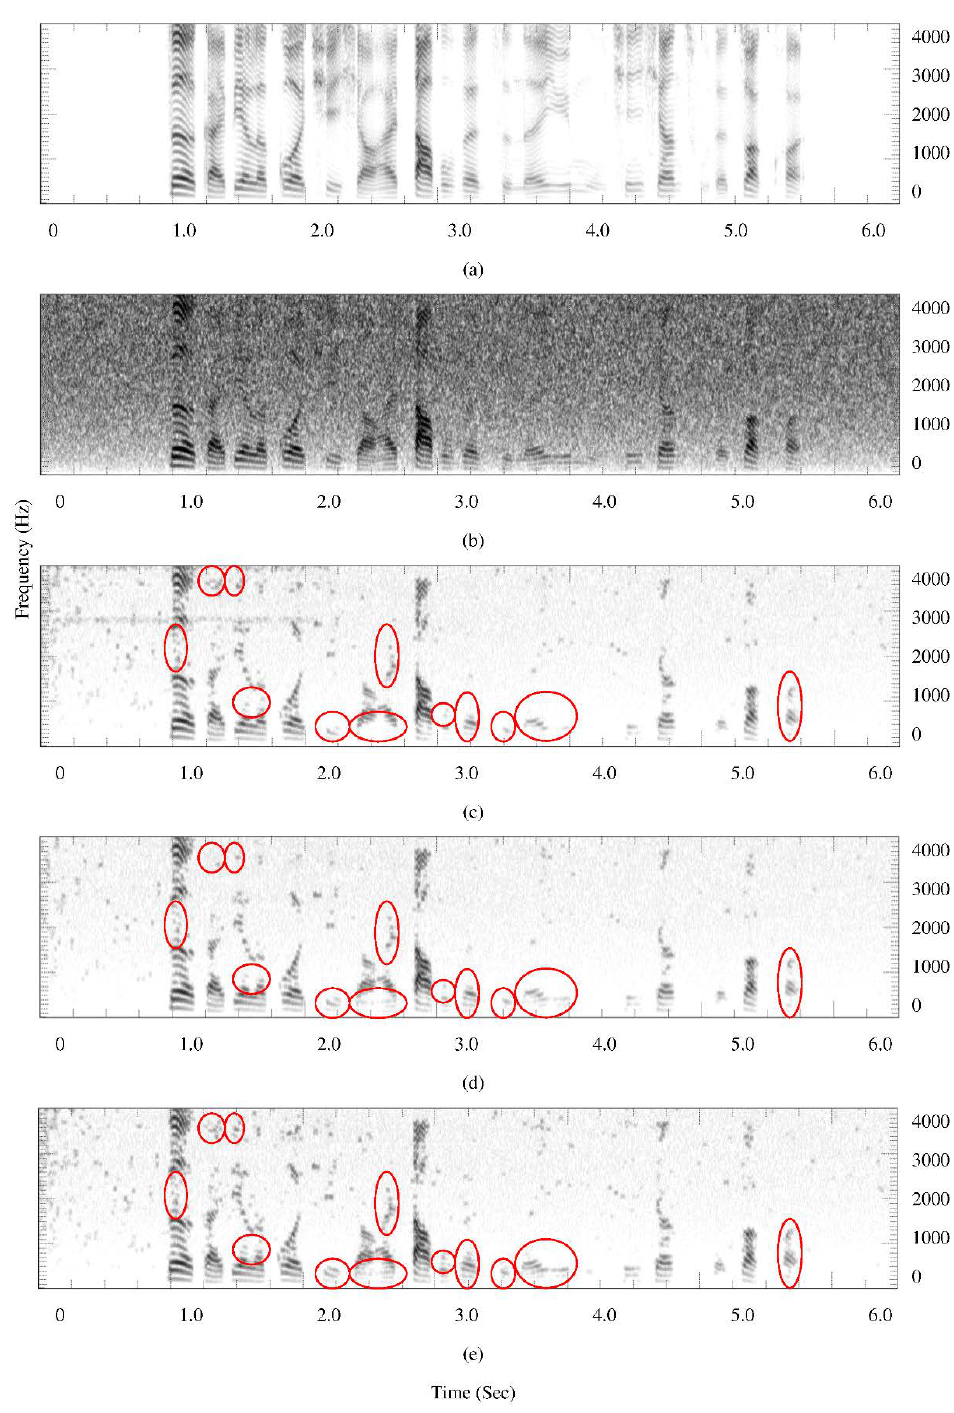
Figure 8. Spectrograms of speech spoken by a male speaker, ( a ) clean speech; ( b ) noisy speech interfered by white noise with average SegSNR = 0 dB; ( c ) denoised speech using the MCRA noise estimator; ( d ) denoised speech using the forward-backward MCRA noise estimator; ( e ) denoised speech using the proposed noise